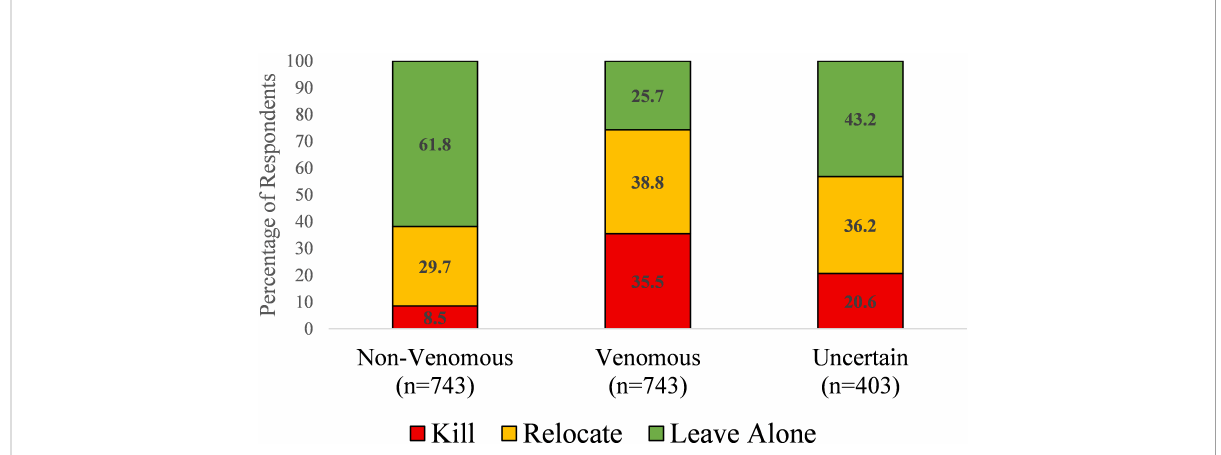
FIGURE 1 Frequency of reported tolerance of snakes (measured as intent to kill, relocate, or leave alone snake that was found “ right outside of your residence ” ) among college students (n = 743) in North Carolina based on three hypothetical scenarios: encountering a non-venomous snake, a venomous snake, or a snake whose identity is uncertain. Sample size for the uncertain snake scenario (n = 403) is smaller because this option was only presented in the second year of the